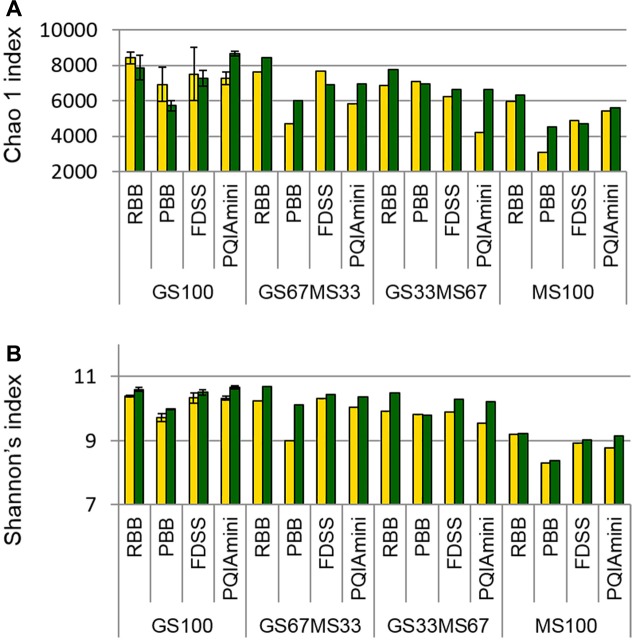
Chao1 richness index (A) and Shannon’s diversity index (B) values for all four DNA extraction methods (RBB, PBB, FDSS, and PQIAmini) applied to rumen fluid (yellow) and fibrous content (green) samples from four dairy cows each fed different ratios of grass silage (GS) to maize silage (MS), e.g., GS67MS33 is a diet containing 67% grass silage and 33% maize silage. The GS100 samples represent the mean of two different DNA extracts, and the error bars represent their standard deviation.